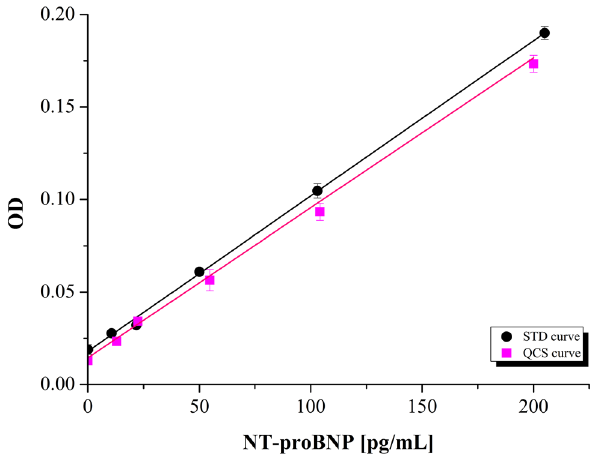
Figure 1. Six-point calibration curves (y = mx + q) obtained from STDs (black) and QCSs (dark pink), and described by y = 0.0008x + 0.01884 (with R 2 = 0.9996) and y = 0.0008x + 0.01438 (with R 2 = 0.9987) for STDs and QCSs,